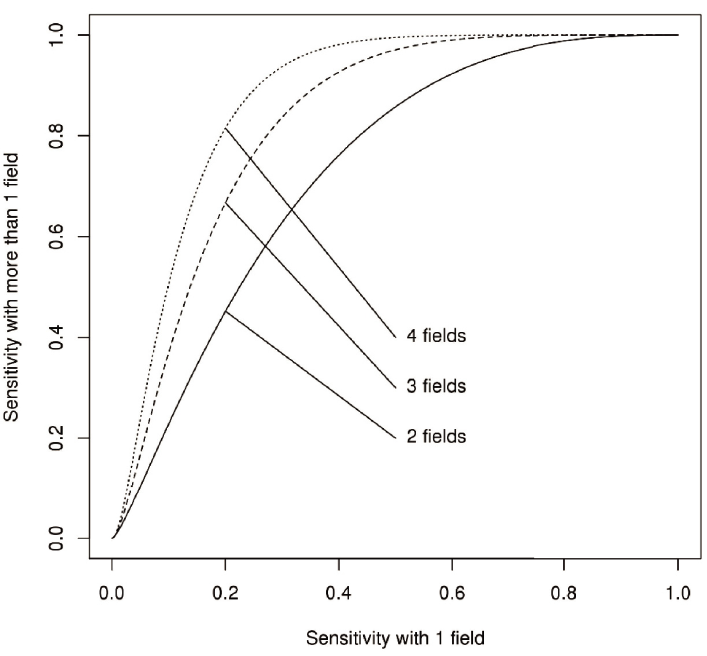
Fig 4. Assay sensitivity comparisons. The improvement in sensitivity that is possible by using multiple fields.